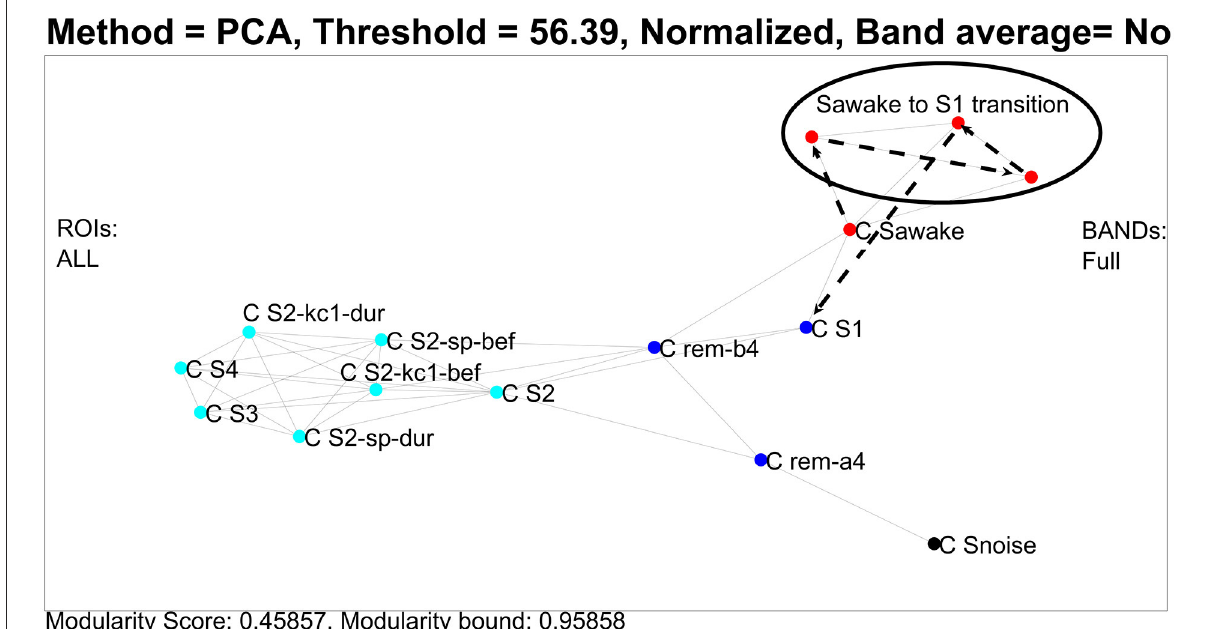
FIGURE3 Clustering and transitions from eyes closed waking (ECW) to Non-REM1 (NREM1) on the semantic map defined by CENTERS of key sleep categories. To produce the figure, 94 (united) nodes were used, which were made up of the 91 nodes from core periods, awake, noise, and NREM2 hallmarks (pre and during spindles and KC1 events), and three nodes from the transition period from ECW to just before the NREM1 period. The details of the computations and what is actually displayed are described in the main text. The CENTER representations of the main categories are displayed in the reduced space of the first two eigenvectors of the PCA analysis providing a semantic map, on which the transition from ECW to sleep is portrayed by connecting (in chronological order) the nodes representing that period. For clarity and to avoid clutter in the display, the labels of the CENTER nodes begin with C and then S for the NREM sleep stage (e.g., C S1 for CENTER of NREM1) and obvious notations for the rest (e.g., C S2-sp- dur for the CENTER of the NREM2 period during